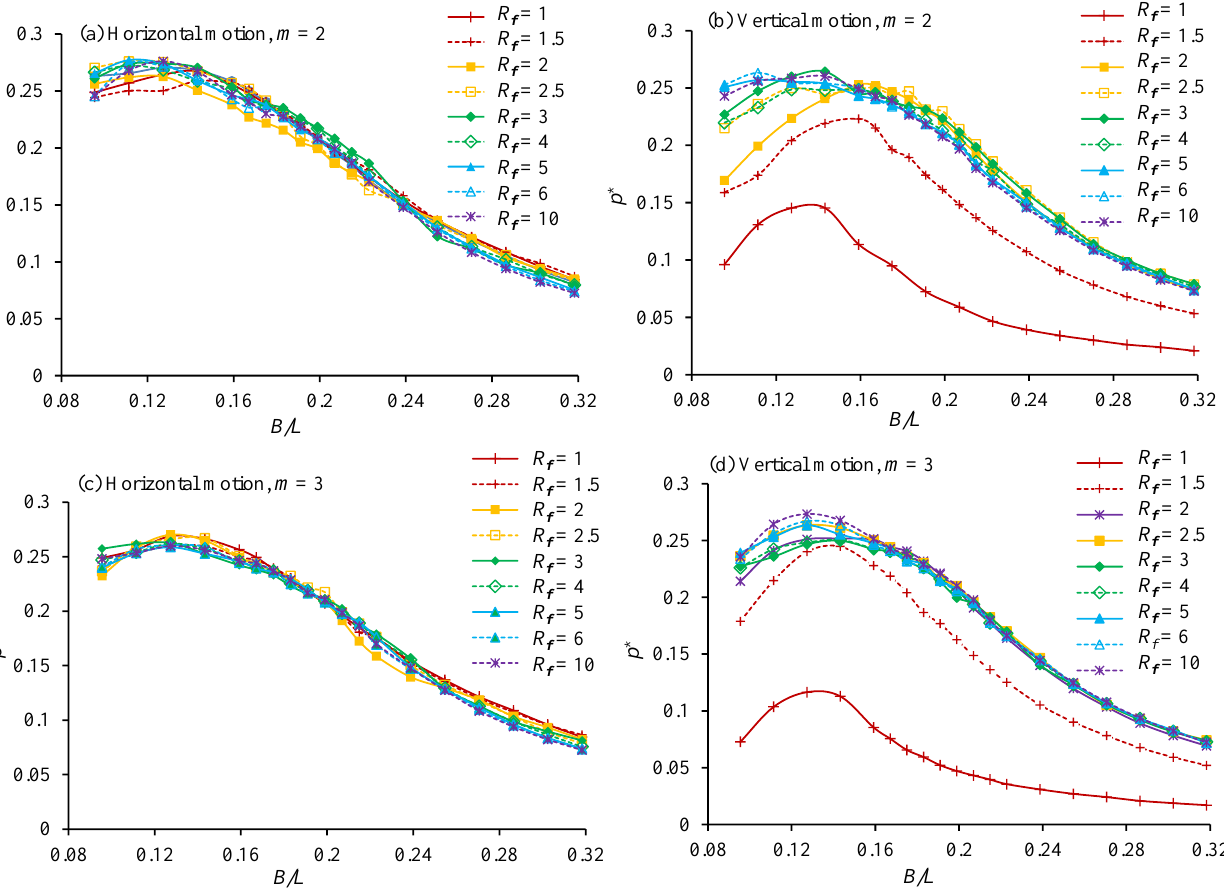
Figure 4. Variation of the amplitude of air pressures oscillatory of the floating OWC chamber with B / L for K t = 3000 Pa · m − 3 · s and various frequency ratios at d / h = 0.25. If the OWC oscillates vertically, the phase difference between the vertical motions of the OWC and the water surface motion, which is defined as ϕ , affects the volume change and the efficiency. Figure 8 shows the variation of the phase difference ϕ with B / L for K t = 3000 Pa · m − 3 · s for the vertical motion of the OWC device. The value of ϕ is found to continuously increase with the increase of R f until R f = 10 for the vertical motion of OWC device. Both A Y and η * increase if R f decreases, but the largest amplitudes of oscillation and wave surface elevation at R f = 0 produce the smallest power, as shown in Figure 3, because the very small phase ϕ difference between them creates a very small change in the OWC volume or air flow rate. With the increase of R f , the increase in ϕ is in favour of power generation, but the decreases in A Y and η * cause the reduction in power generation. The combination effects of ϕ , A Y , and η * make the maximum best efficiency occurring at R f = 10, K t = 3000 Pa · m − 3 · s, and d / h =